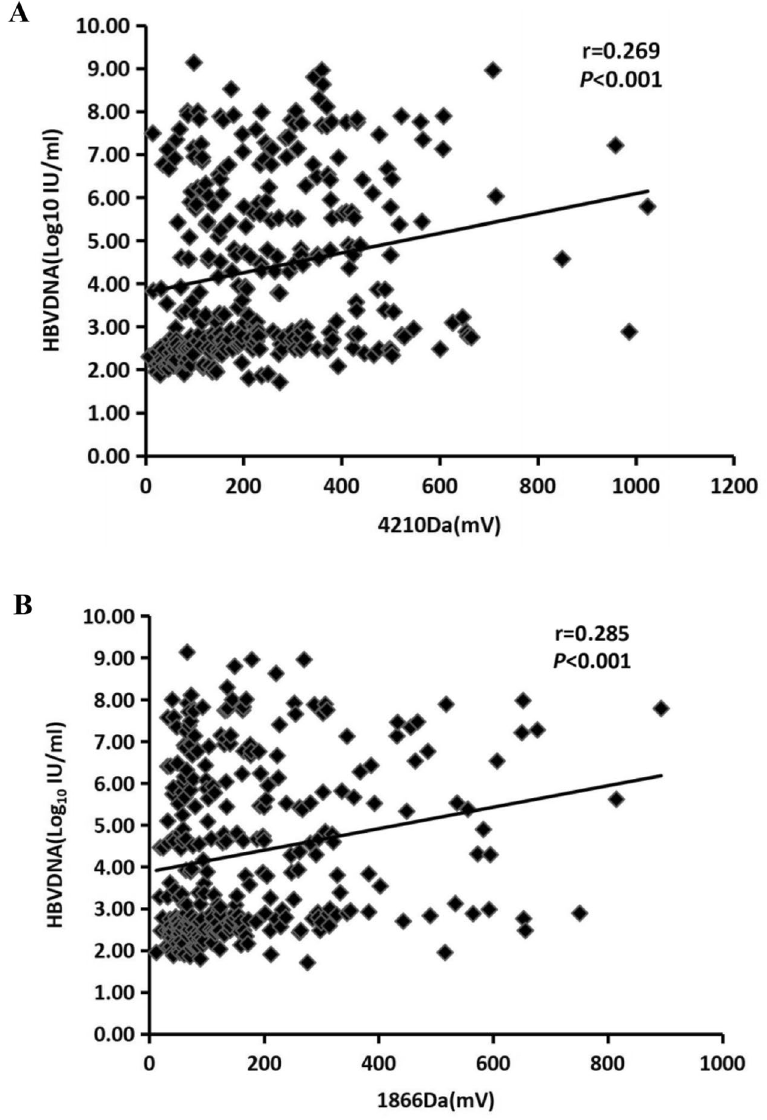
Figure 4. Correlation between serum HBV DNA levels and polypeptide levels in CHB, LC, and HCC patients. ( A ) Correlation between serum HBV DNA levels and 4210 Da polypeptide levels. ( B ) Correlation between serum HBV DNA levels and 1866 Da polypeptide